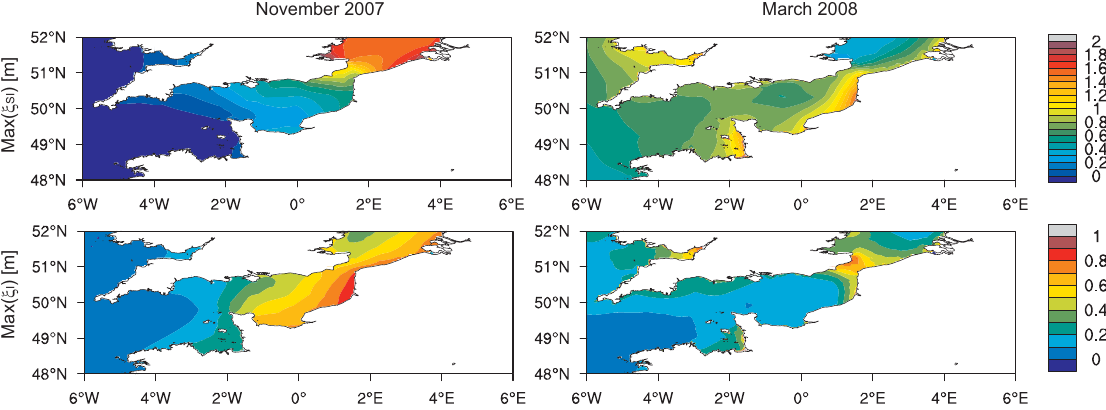
Fig. 5. Maximum value of the practical storm surge ξ SI (left) and the residual tide-surge interaction elevation ξ I (right), for the two events of November 2007 (above) and March 2008 (below). Data interval: 12-minutes. Table 2. Synthesis of characteristics values of practical storm surge ξ SI and tide-surge interaction elevation ξ I for the studied events (Ev. 1: November 2007; Ev. 2: March 2008) and locations. Time t S indicates the time at which | ξ SI | is highest during the event. Num- bers in italics indicate the corresponding value of ξ SI or ξ I when it is